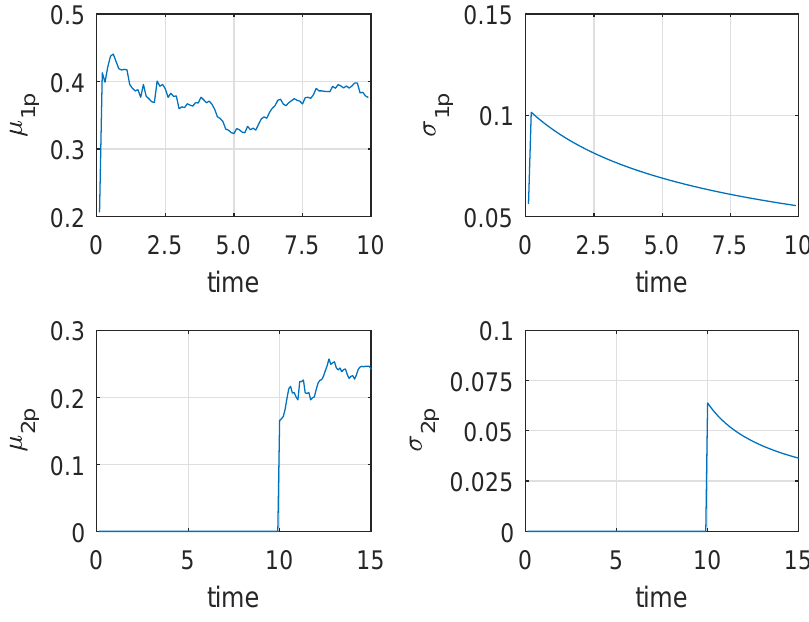
Figure 5. The updating of estimated parameters based on Bayesian